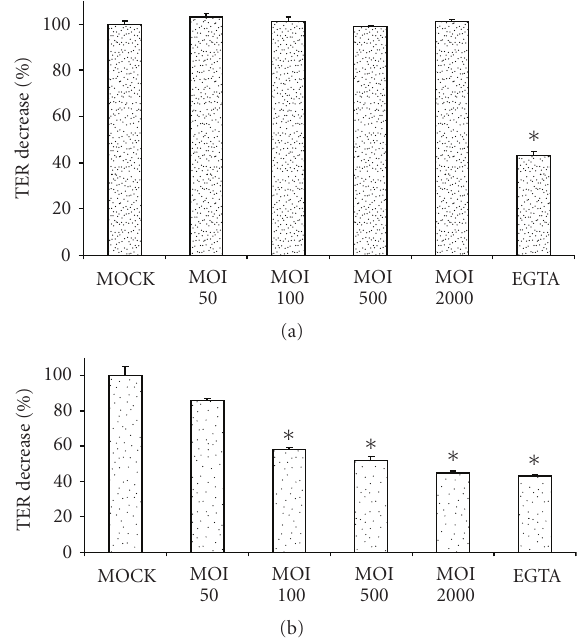
Figure 2: E ff ect of LV transduction on TER . Polarized 16HBE41o- cells were incubated with di ff erent MOIs and, 4 or 24 hours later, TER was measured. Mock is represented by cells incubated with medium only. As a positive control, cells were incubated with 12mM EGTA for 30 minutes. TER values are shown as % of mock cells that were 523 ± 44 Ohm × cm 2 . Data are expressed as means ± SD of three experiments. A: ∗ P < . 05 for EGTA versus mock. B: ∗ P < . 05 for EGTA, 100, 500, and 2000 MOIs versus